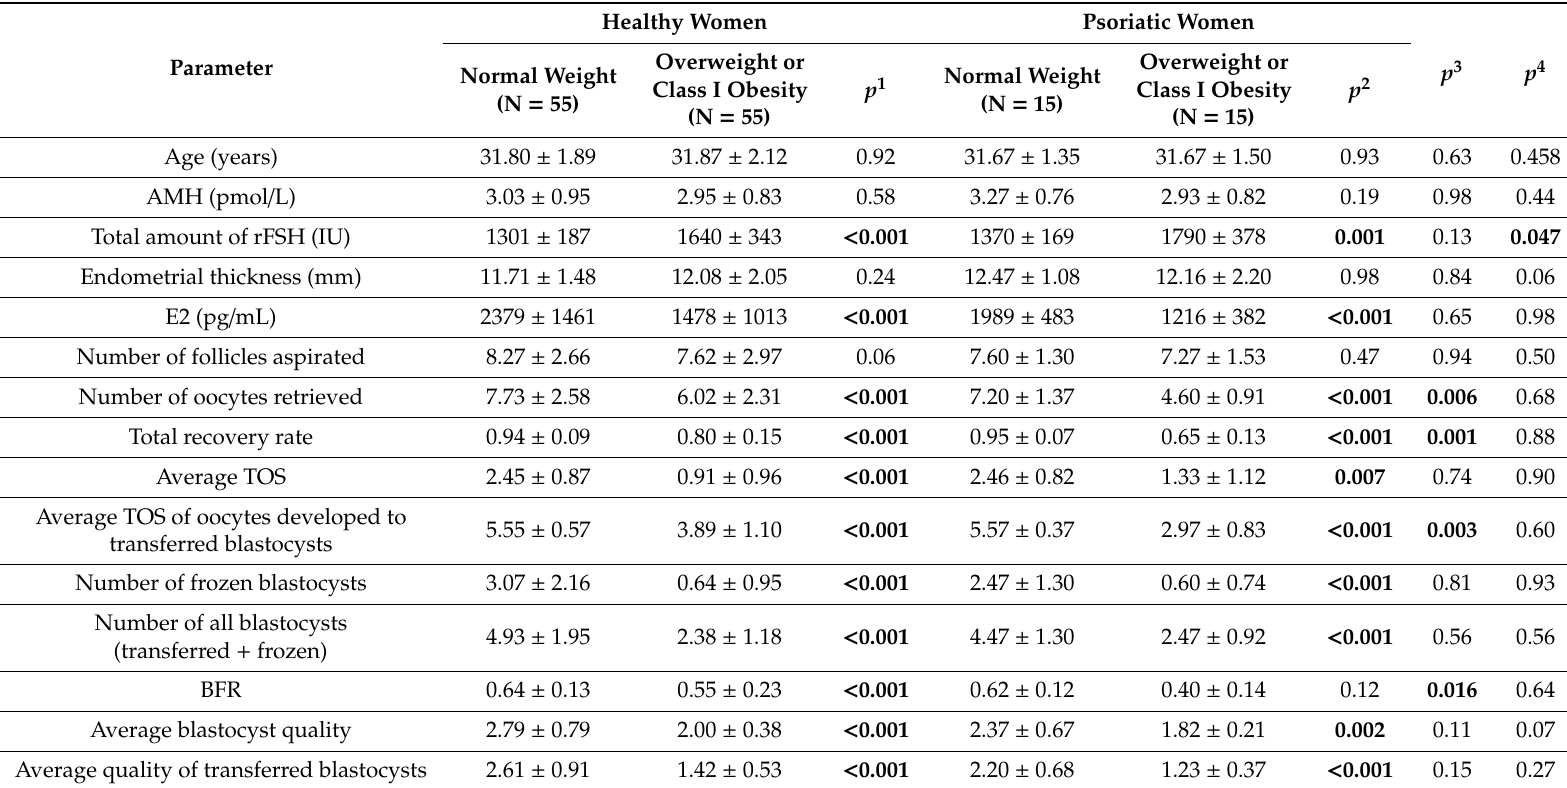
Table 1. The course of intracytoplasmic sperm injection (ICSI) procedure in both healthy and psoriatic women with normal weight and overweight or Class I obesity. Data are presented as M ±